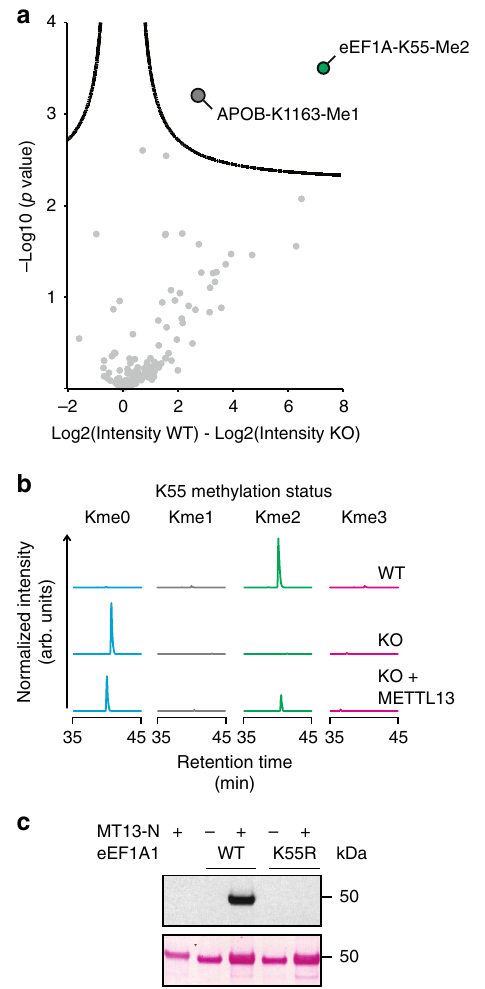
Fig. 5 MT13-N catalyzes methylation of eEF1A-Lys55. a Volcano plot showing differences in the mean MS intensities for lysine methylation sites in HAP-1 WT and METTL13 KO cells. Curved lines represent the signi fi cance cutoff (FDR = 0.01 and s0 = 0.1). The signi fi cant sites, dimethylation of Lys55 in eEF1A (eEF1A-K55-Me2), and monomethylation of Lys1163 in APOB (APOB-K1163-Me1), are indicated. b Ion chromatograms representing the different methylated forms of eEF1A- Lys55 in WT, KO, and KO cells complemented with FLAG-tagged METTL13 (KO + METTL13-FLAG). c Evaluation of a Lys55-to-Arg (K55R) mutant of eEF1A1 as a substrate for MT13-N. eEF1A1 constructs were incubated with MT13-N as indicated and methylation was visualized by fl uorography (top panel). The corresponding Ponceau S-stained membrane is shown to assess for protein loading (bottom